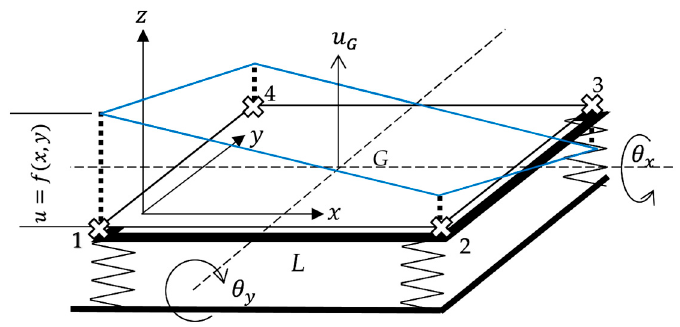
Figure 3. Deformed shape of the rigid plate under prescribed force at node 1.